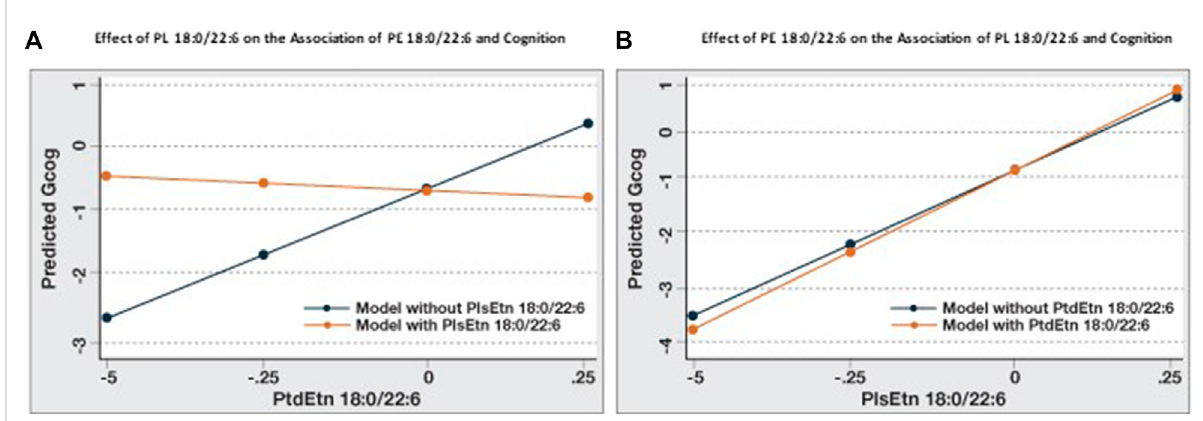
FIGURE 2 Association of PE 18:0/22:6 with cognition is modulated by PL 18:0/22:6. Regression analyses were conducted with Gcog as the outcome variable and PE 18:0/22:6 or PL 18:0/22:6 as the independent variable. Two separate models for each phospholipid, with or without the counterpart phospholipid in the model, were constructed. All models were adjusted for age, sex and education. Postestimation predicted value of the outcome variablebybrainlevelsofthephospholipidwereplottedinasinglegraphforcomparison. (A) EffectofPE18:0/22:6oncognitionwithorwithout PL 18:0/22:6 in the model; (B) Effect of PL 18:0/22:6 on cognition with or without PE 18:0/22:6 in the